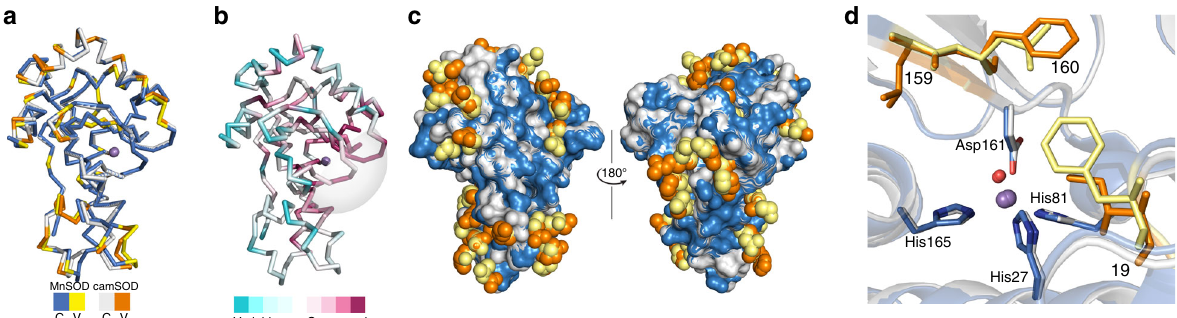
Fig. 2 Mutation of two residues located close to the active site inverts speci fi city. a Superimposed ribbon representation structures of the polypeptide backbones showing conserved (C) regions of the manganese-loaded forms of MnSOD (blue) and camSOD (gray), with all variable (V) residues highlighted (yellow and orange, respectively). b Analogous ribbon representation of the structure of S. aureus MnSOD, illustrating the localization of variable (cyan) and conserved (purple) regions of SOD sequence based on ConSurf analysis 59 of 500 SOD sequences (calculated conservation scores represented by the color spectrum key). Approximate dimerization interface is indicated (gray). c Superimposed space- fi lling models of MnSOD and camSOD, colored as in panel ( a ), illustrating that >85% of sidechains that vary between the S. aureus SODs are surface-exposed (2.5 Å 2 surface exposure cutoff used). d Magni fi ed view of the superimposed cartoon representations of MnSOD and camSOD structures, colored as in panel ( a ), showing the spatial location of the three residues targeted for mutagenesis in proximity to the manganese ion